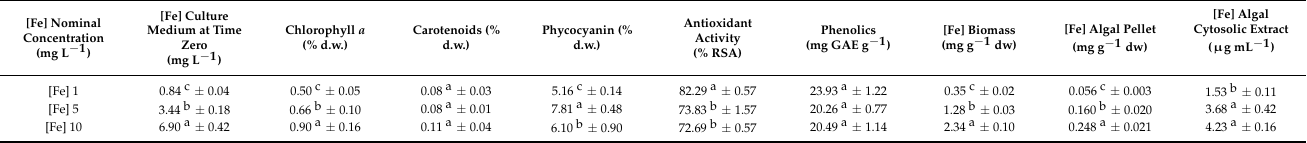
Table 1. Iron concentration in the culture medium at time zero and chlorophyll a , carotenoids, phycocyanin, antioxidant activity, phenolic content, iron concentration in the biomass, algal pellet, and cytosolic extract at the end of cultivation of A. platensis F&M-C256 are reported for each iron nominal concentration of 1, 5, and 10 mg L − 1 . Values are reported as means ± SD ( n = 3). Different letters in a column indicate a significant difference ( p < 0.05).